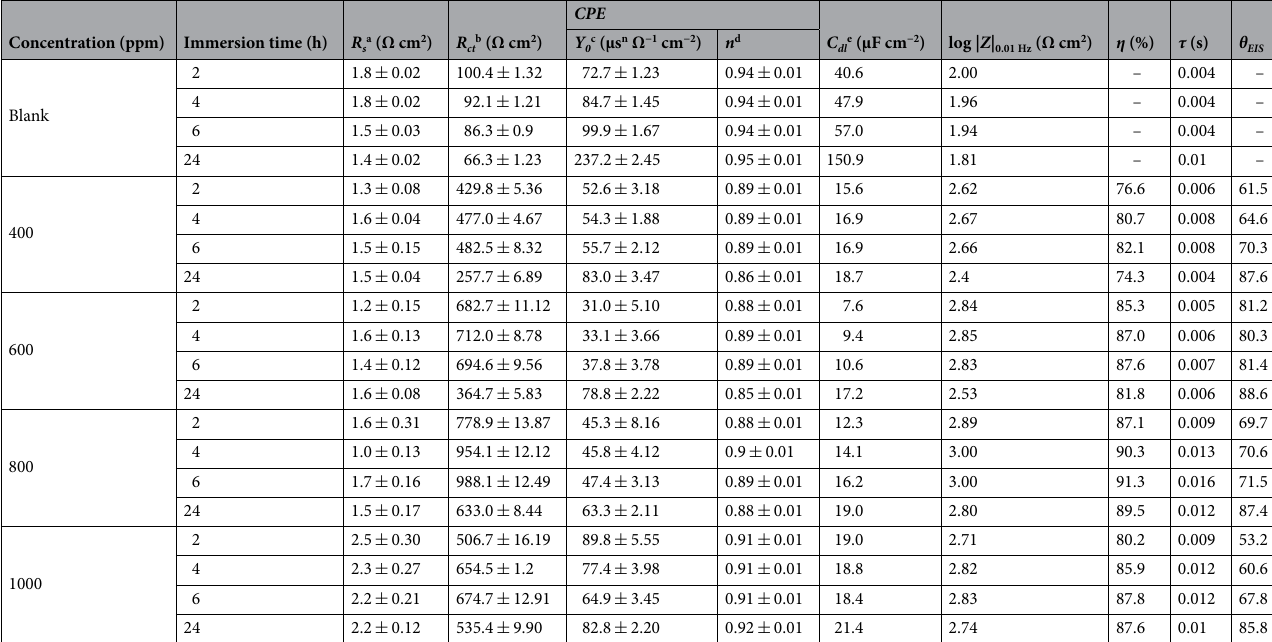
Table 1. Electrochemical parameters attained from fitted EIS data. a Standard deviation changed between 1.5 and 2.1% b Standard deviation changed between 2.6 and 3.2% c Standard deviation changed between 2.2 and 4.7% d Standard deviation changed between 1.9 and 3.5% e Standard deviation changed between 3.1 and